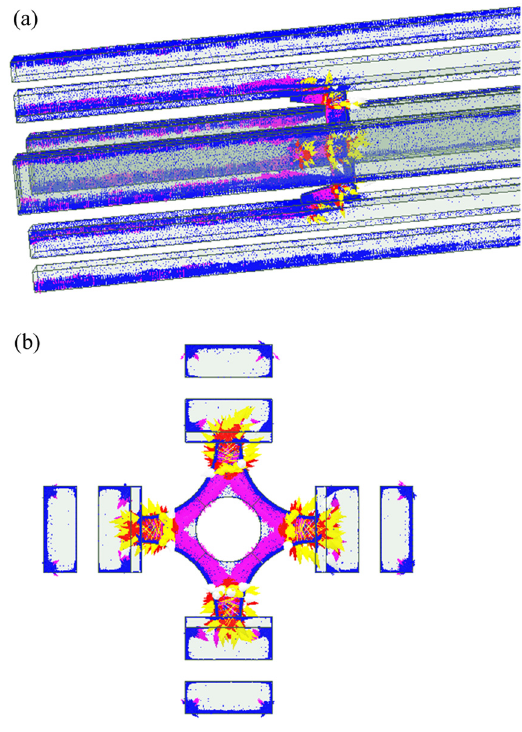
Figure 18: The electromagnetic force of the proposed ECFREL. ( a ) Front view and ( b ) top view.